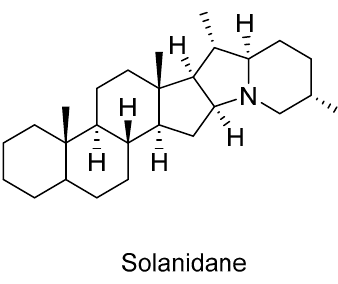
Figure 6 . Selected alkaloids with antivenom activity